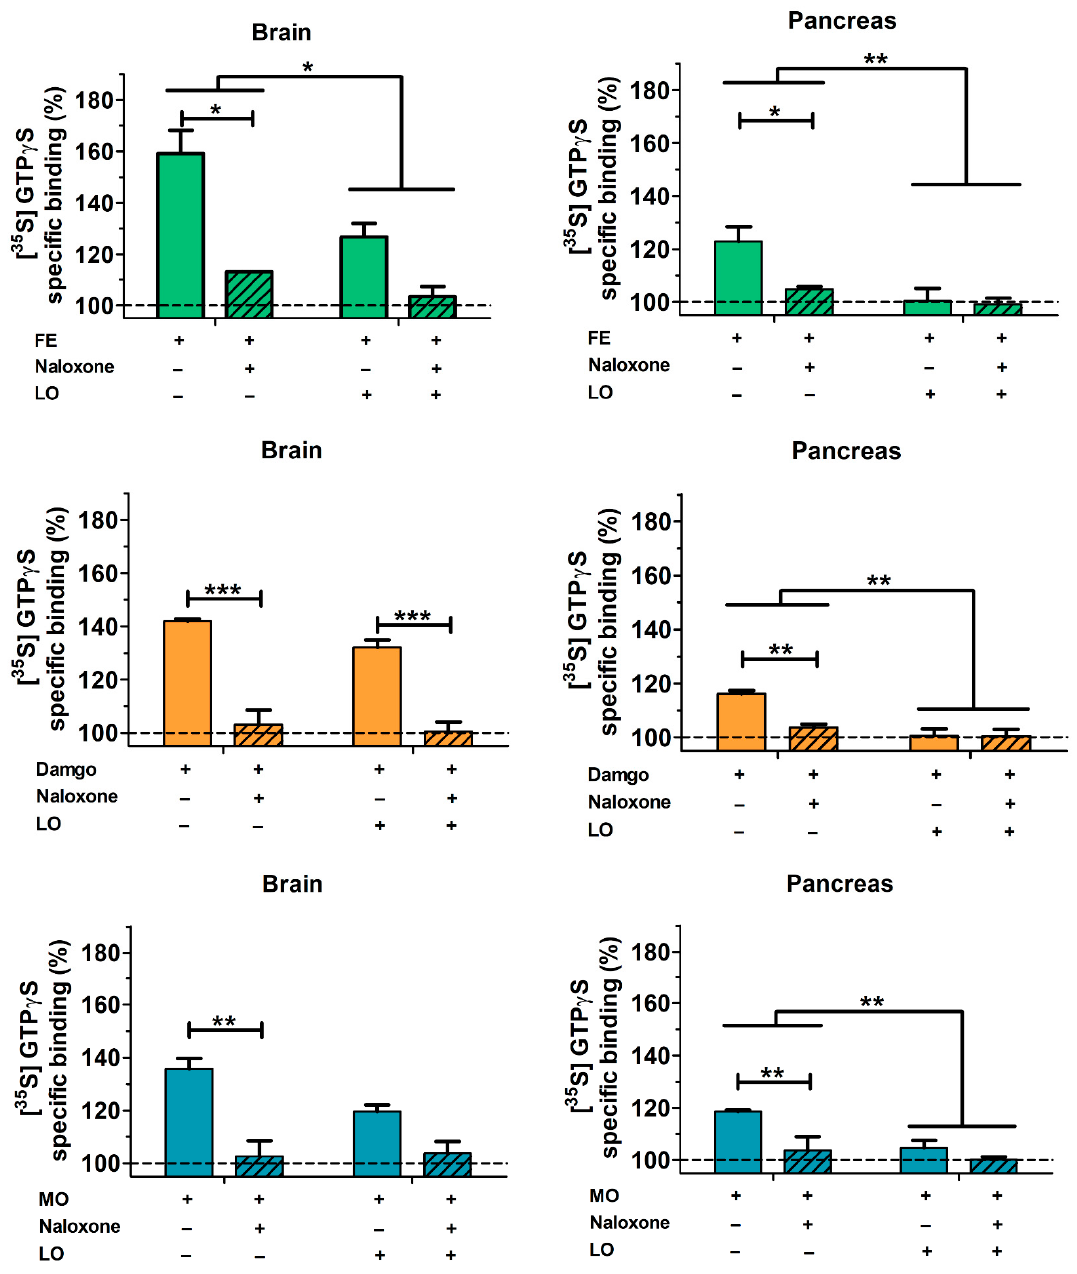
Figure 11. Stimulation of G-protein activation in rat brain and pancreas membrane homogenates. Tissue samples were derived from control and AP animals. Treatments of pancreatic homogenates were as follows: 10 µ M FE; 10 µ M DAMGO; 10 µ M MO. Striped bars represent the combined treatment with mu receptor ligands (FE, MO, DAMGO) and equimolar naloxone. Values represent mean with standard error, n = 6. Two-way ANOVA was performed followed by Bonferroni post hoc test. * p < 0.05, ** p < 0.01; *** p < 0.001.